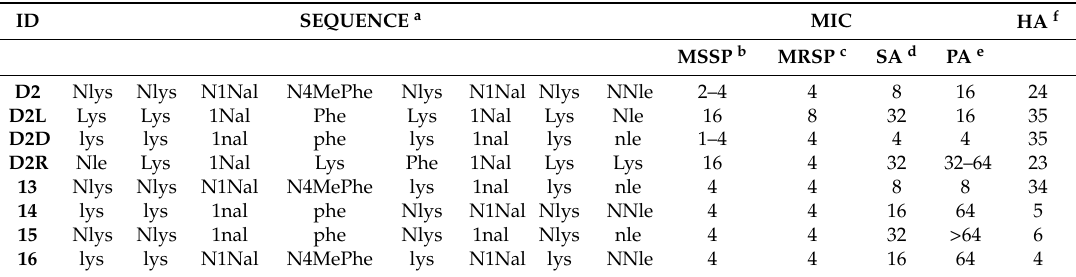
Table 3. Structures, antimicrobial (MIC, µ g/mL), and hemolytic activity (% at 150 µ M) of L - ( D2L ), D - ( D2D ), retro- ( D2R ), and peptide–peptoid hybrid analogues ( 13 – 16 ) of D2